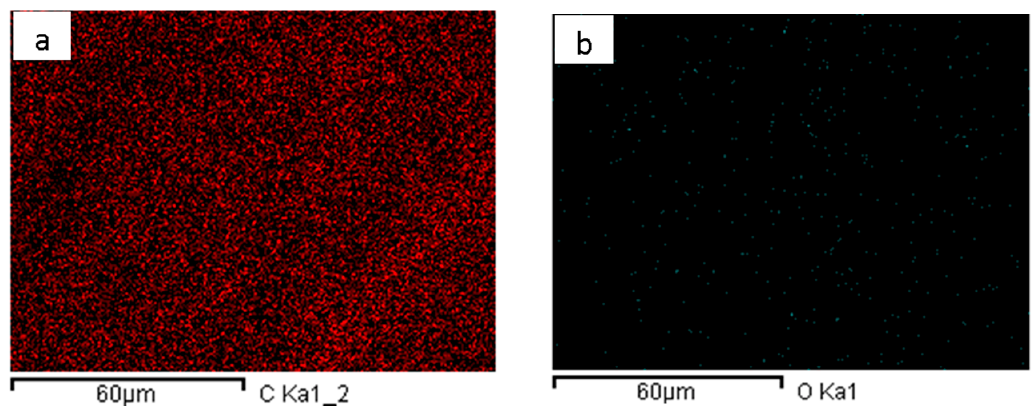
Figure 5. SEM Images of ( a ) bare LDPE pellet and ( b ) TiO 2 ‐ LDPE pellet.